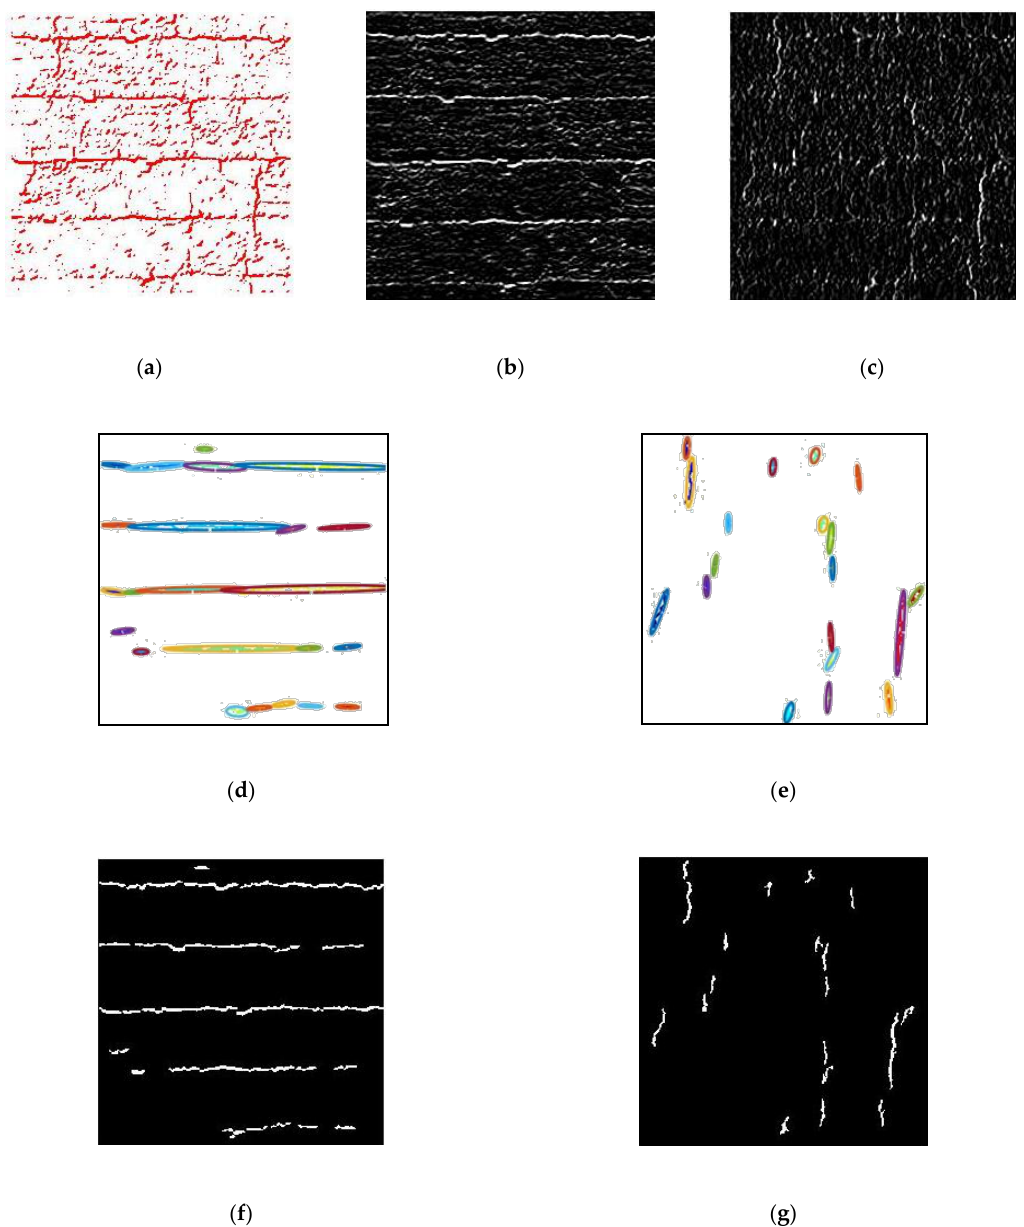
Figure 16. Evaluation of the algorithm on surface images of earthen heritage. ( a ) Image 3, ( b ) horizontal edge map, ( c ) vertical edge map, ( d ) horizontal CCs (area > 30 pixels), ( e ) vertical CCs (area > 30 pixels), ( f ) architectural feature map and ( g ) crack map.